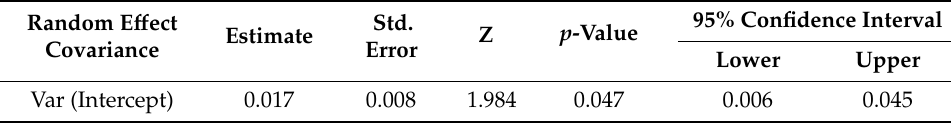
Figure 3. Individuals by race and gender with hypertension and BMI between 30 and 35 vs. individuals by race and gender without hypertension and BMI below 30.